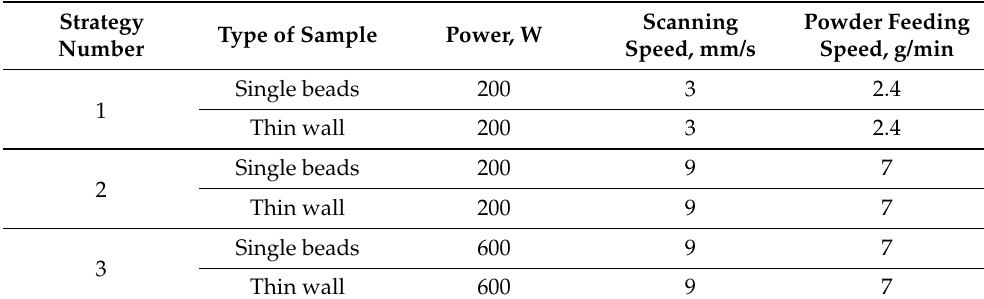
Figure 1. Scanning strategies for cladding thin walls. Table 1. Cladding